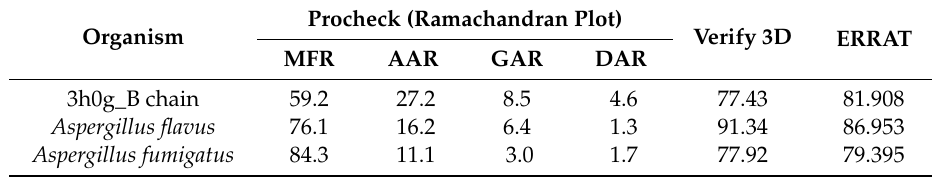
Table 1. Stereo-chemical parameters of the RNAP protein models and the template assessed at the SAVES server.